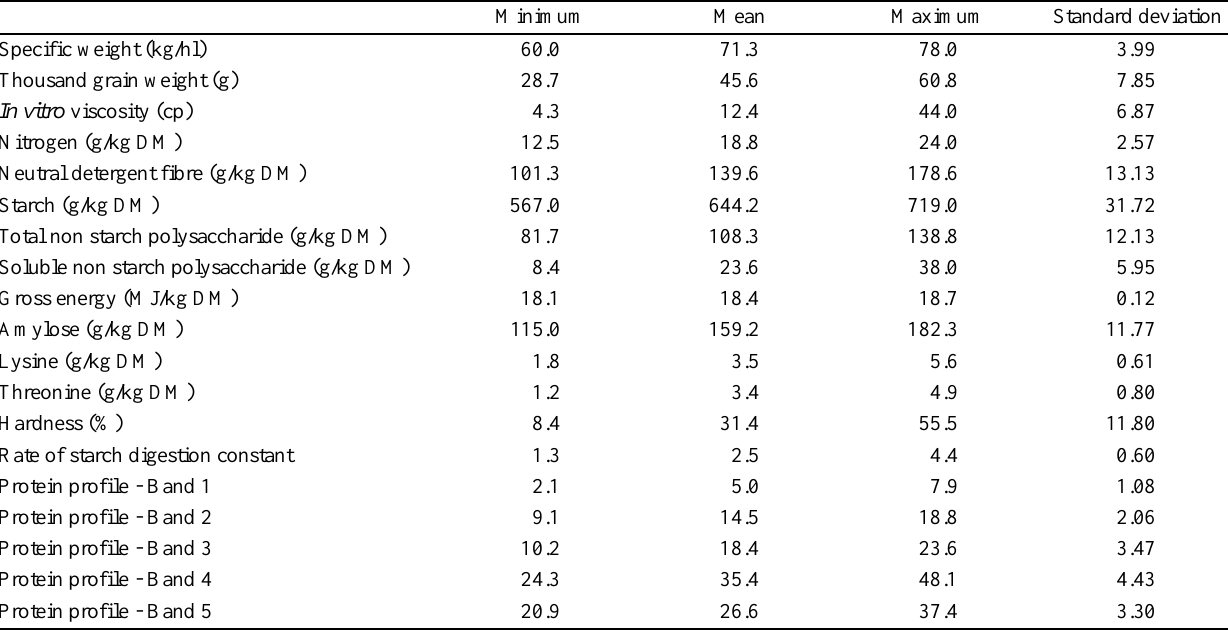
in Table 4(a), (b) and Table 5. Total DMI, LWG and gain:feed were positively correlated with TG, in vitro